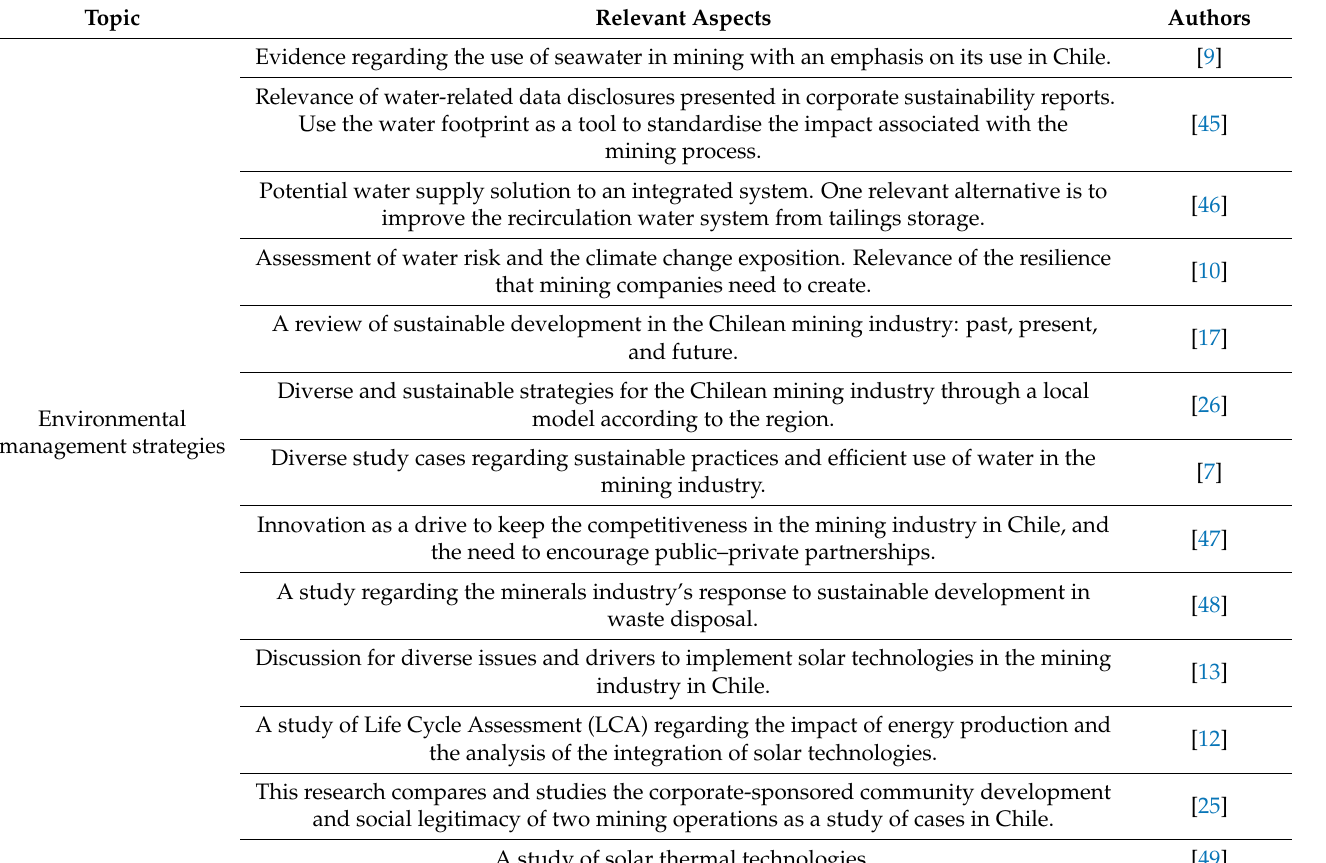
Table 1. The most relevant literature regarding the study topics.